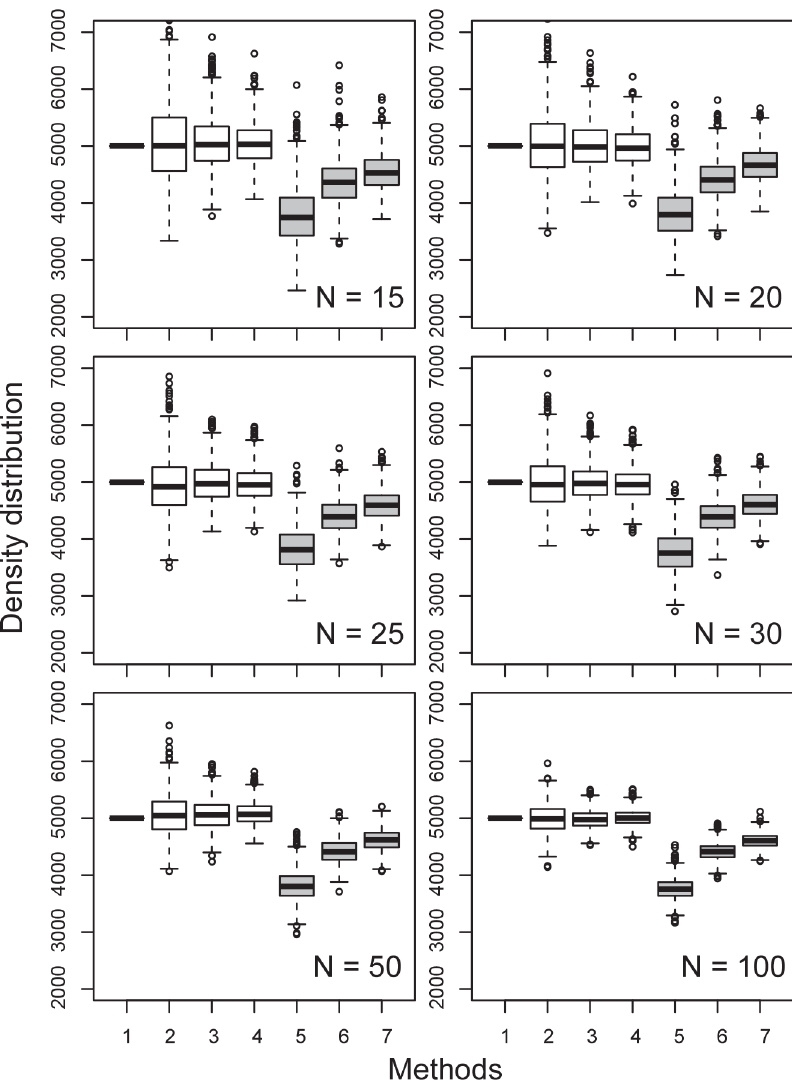
pattern with a density of 5000 individuals ha – 1 . Boxes with white background represent densities based on corrected estimators and those with grey background represent densities based on published